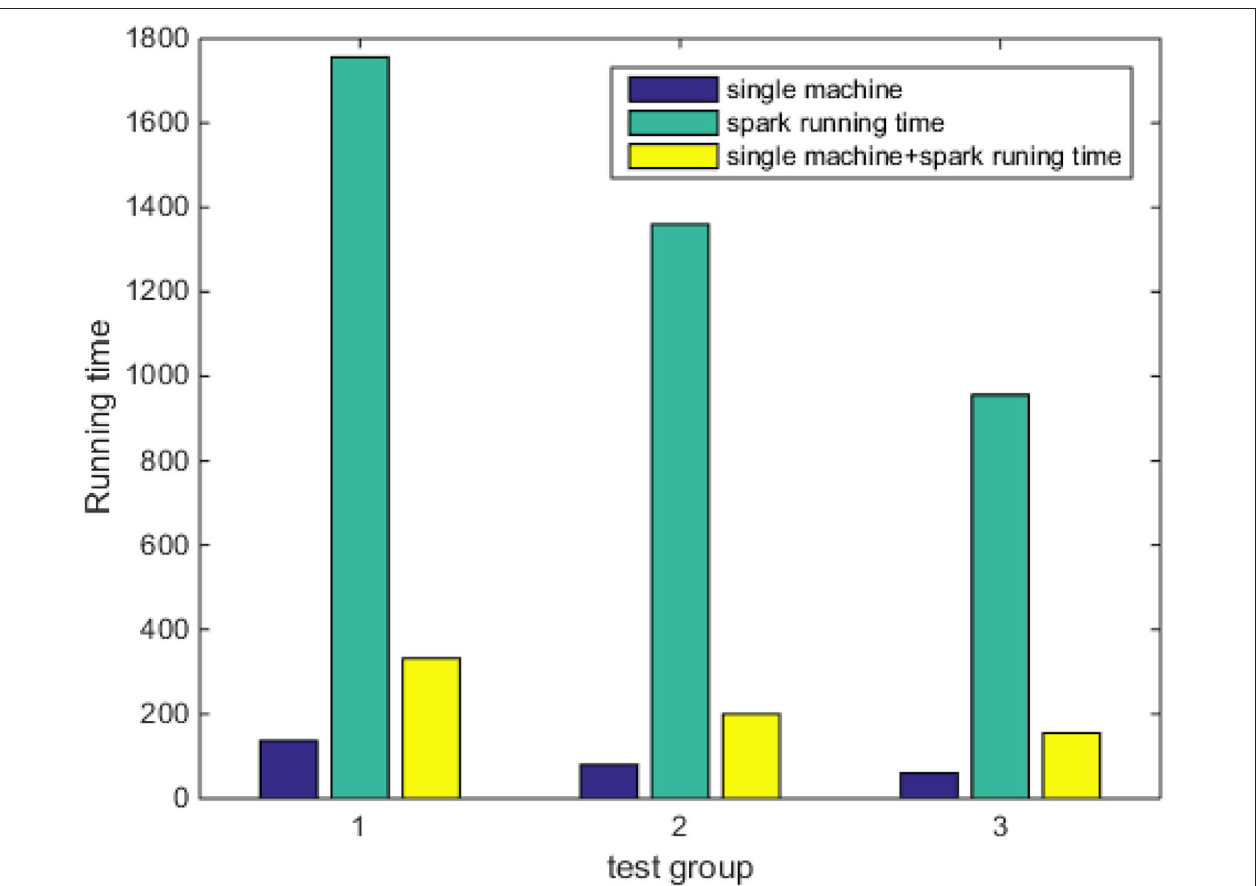
FIGURE 9 | Comparison of model training